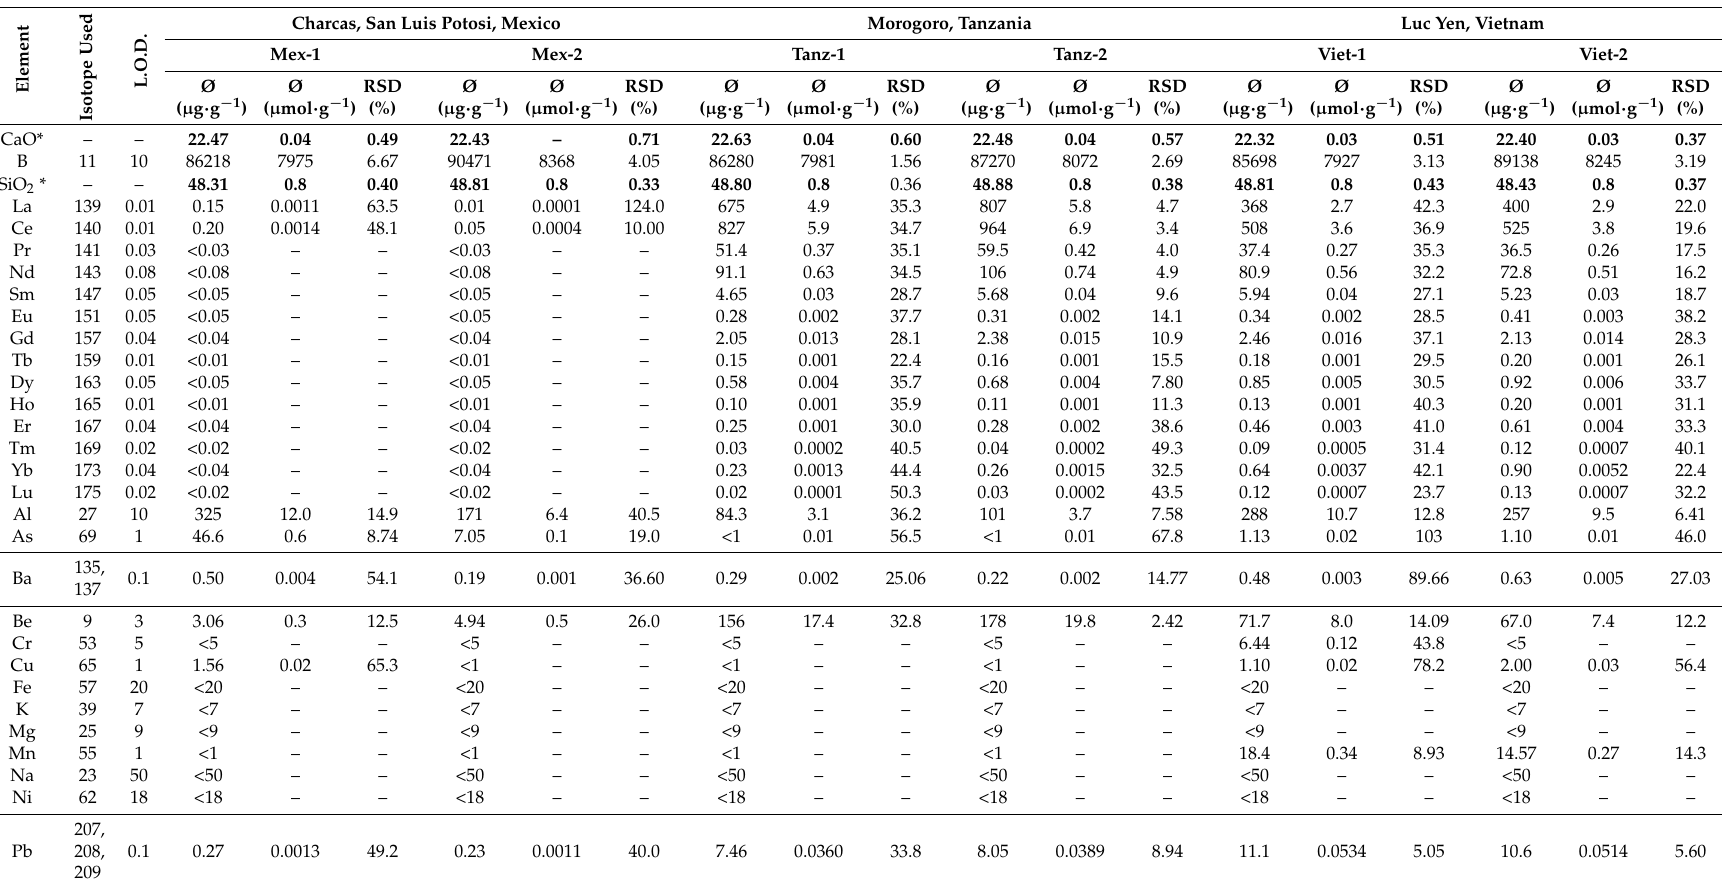
Table 3. Average chemical composition (in µ g · g − 1 and µ mol · g − 1 ) and relative standard deviation (RSD, %) obtained from danburite of three different occurrences. All concentrations were obtained by fs LA-ICP-MS ( n = 12 line scans), except CaO and SiO 2 , which were evaluated with Electron Probe Microanalyzer (EPMA) (averaged from n = 20 spot analyses per